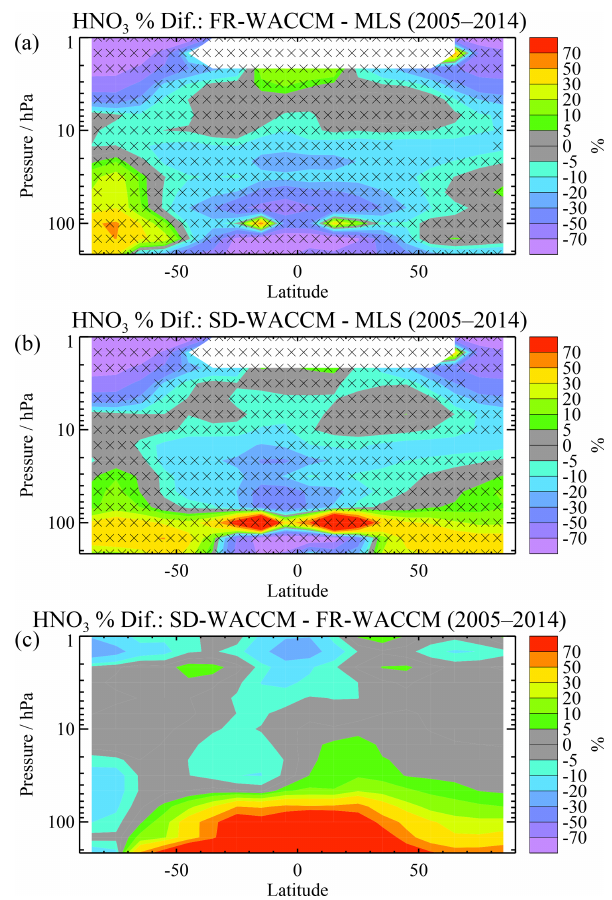
Figure 6. Same as Fig. 1 but for stratospheric HNO 3